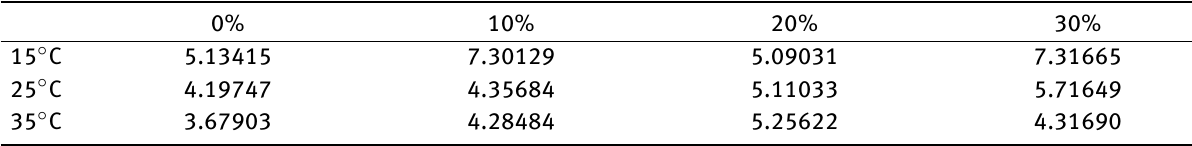
Table 5: The probability deviation of ZSV corresponding to the test results is shown Table 4 ( × 10 4 Pa · s,